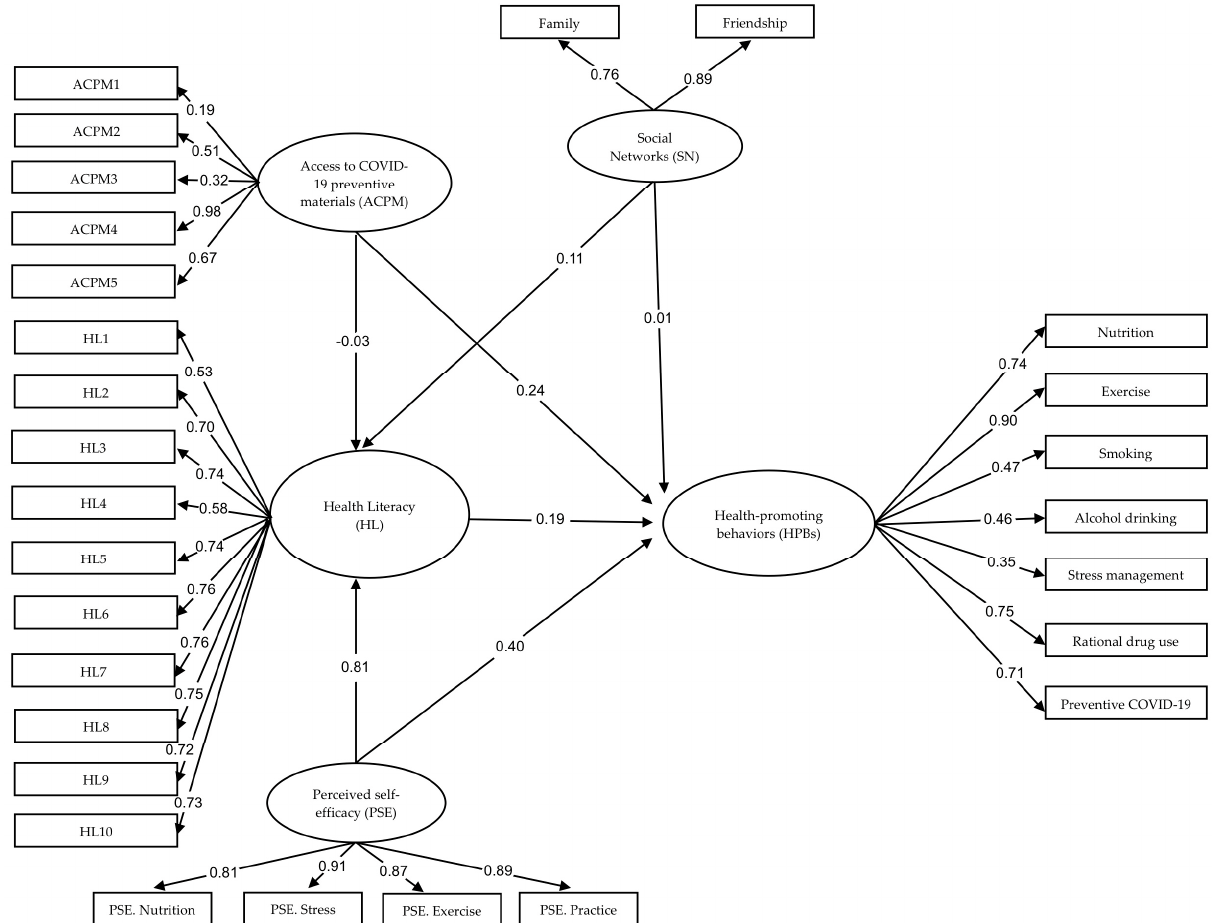
Figure 2. Causal relationship model of HPBs among the older adults with NCDs in our